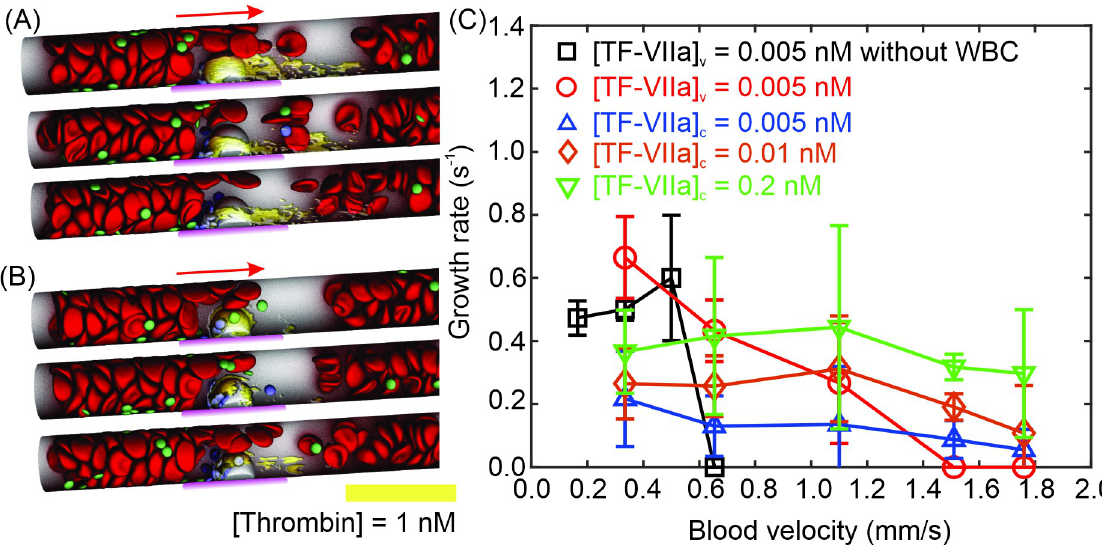
Fig 5. Adhesion of WBCs to the thrombogenic site precipitates the thrombus formation. Three sequential snapshots of platelet activation and adhesion at the thrombogenic site (highlighted by magenta) triggered by (A) vascular expression of [TF-VIIa] cellular expression of [TF-VIIa] c = 0.005 nM on the adhered WBC. See S2 and S3 Movies. Passive platelets (green) become adhesive after exposing to [FIIa] � 1 nM. Yellow color highlights the iso-surface of [FIIa] = 1 nM, within which the platelets become adhesive. RBCs close to the thrombogenic site are omitted for virtualization of the platelet aggregate. Blood flows at a velocity of 0.6 mm/s from left to right. (C) Variation of thrombus growth rates with respect to different blood flow velocities with and without presence of a WBC. [TF-VIIa] nM and [TF-VIIa] c = 0.005 nM, 0.01 nM and 0.2 nM are examined,